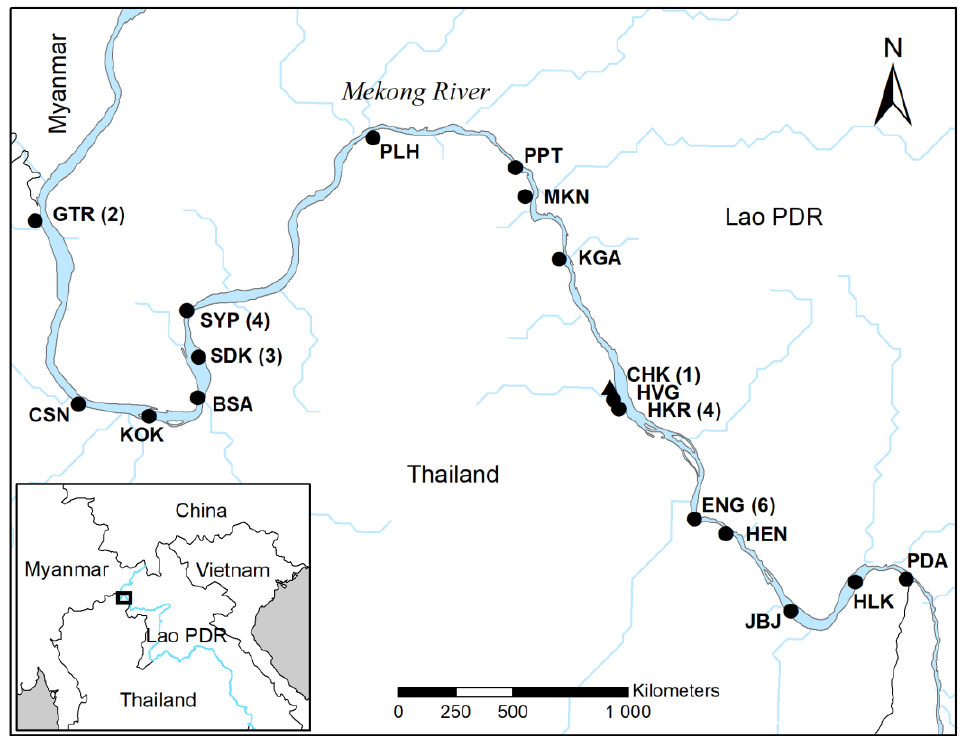
Figure 1. Map of the Mekong River study area in Thailand–Lao People’s Democratic Republic (PDR), 2006–2007. Telemetry receiver locations are marked with black circles and labeled with the receiver site codes (see Table 1 for corresponding site names and additional receiver information). If fish were tagged and released at a receiver site, the number of fish released at that site is shown in parentheses next to the site code. One additional fish release site is marked with a black triangle: CHK (Chiang Khong).